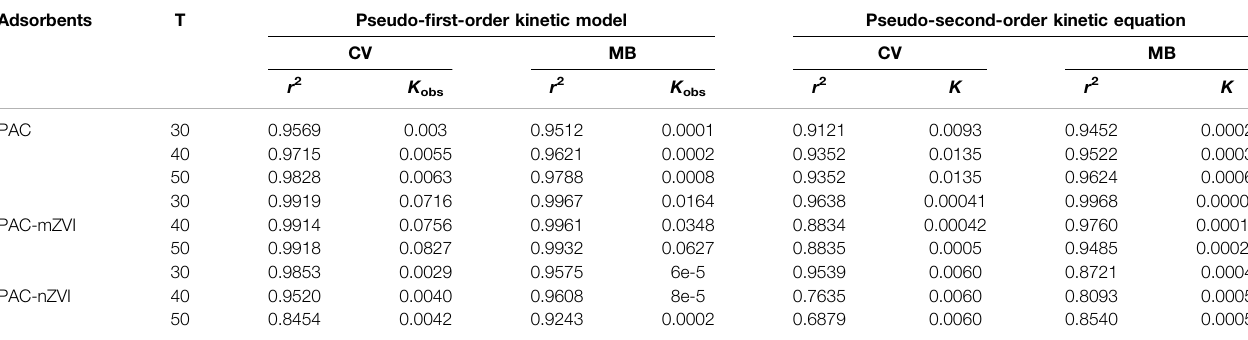
TABLE 3 | Reduction kinetic parameters of CV and MB dyes on PAC and PAC-based ZVI adsorbents. Adsorbents